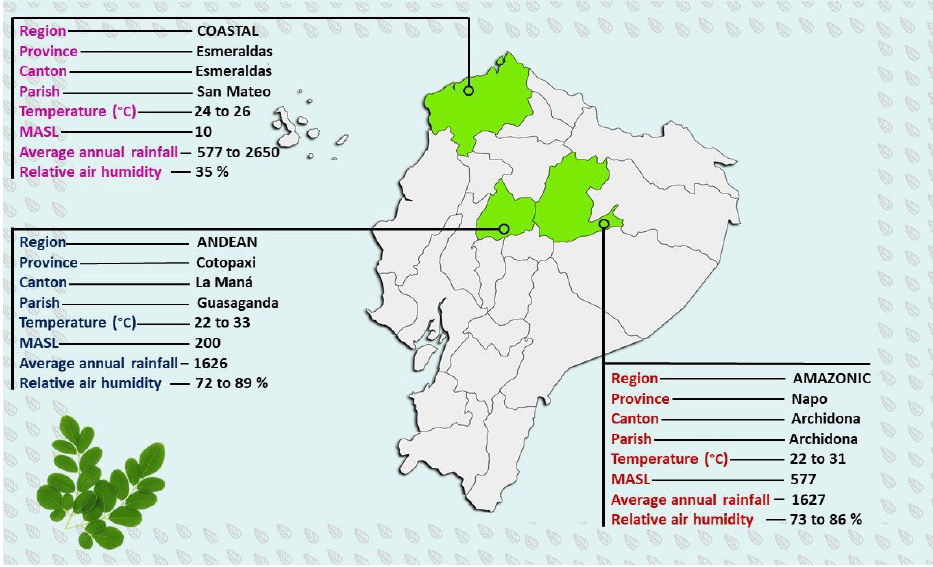
Figure 1. Ecuadorian Moringa oleifera growing sites. MASL: meters above sea